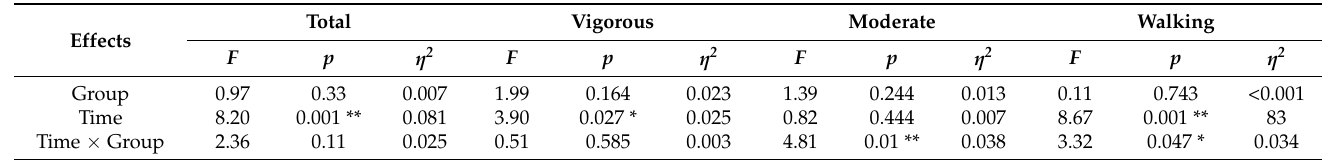
Table 3. Results of repeated-measures ANOVA for all PA variables.